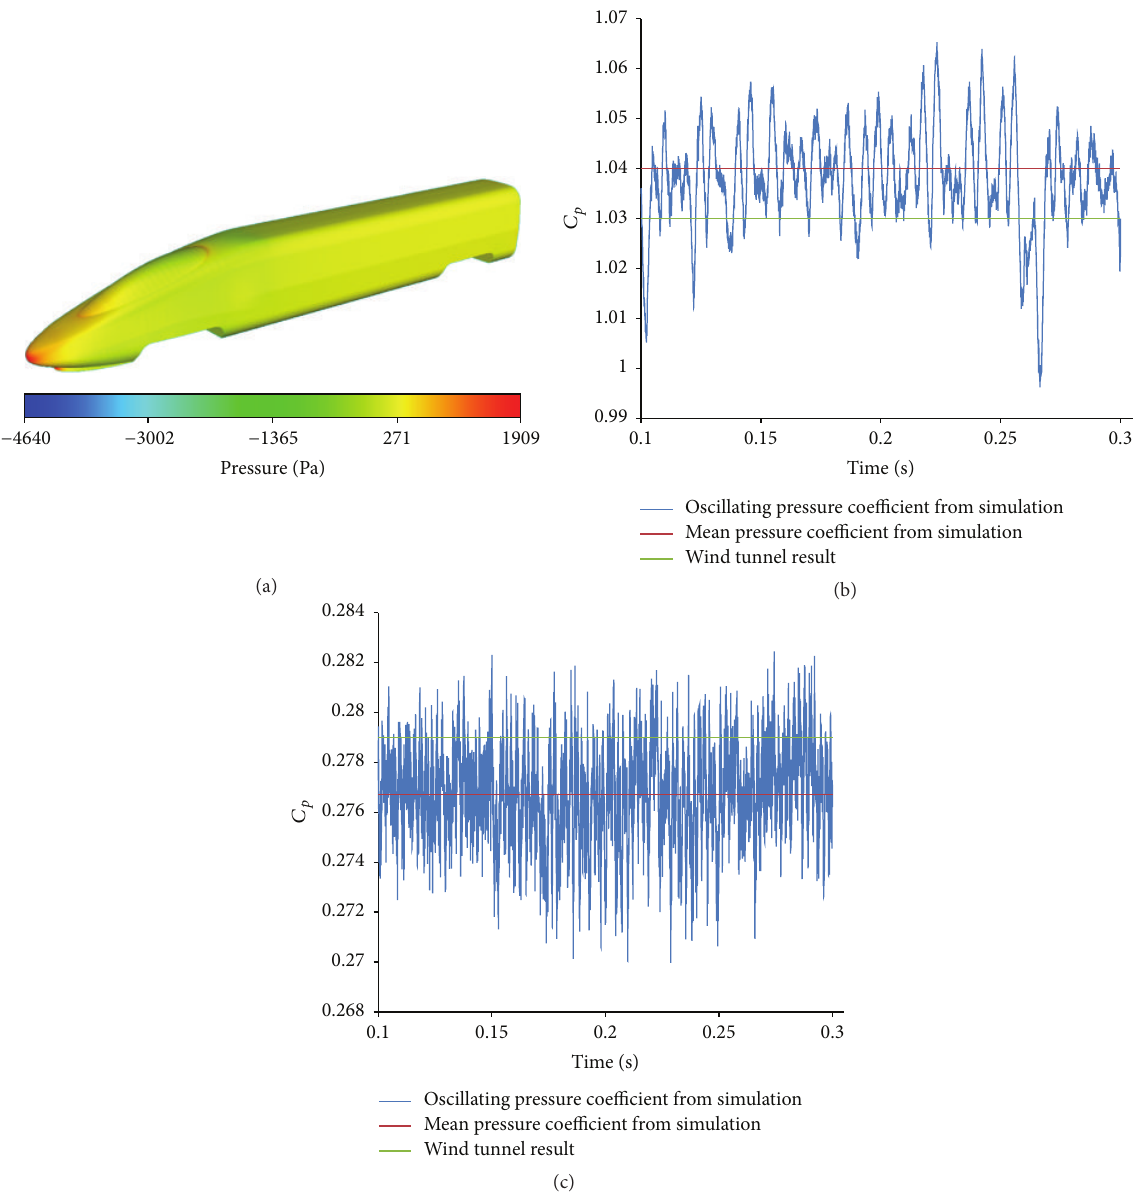
Figure 7: Comparison of pressures and pressure coefficients: (a) simulated pressure distribution on the head train, (b) pressure coefficient at P1, and (c) pressure coefficient at